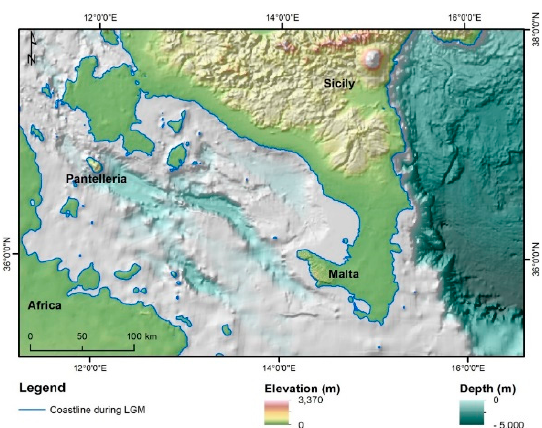
Figure 5. The land bridge between Sicily and Malta (Central Mediterranean Sea) during the LGM (modified after Prampolini et al. [6]).